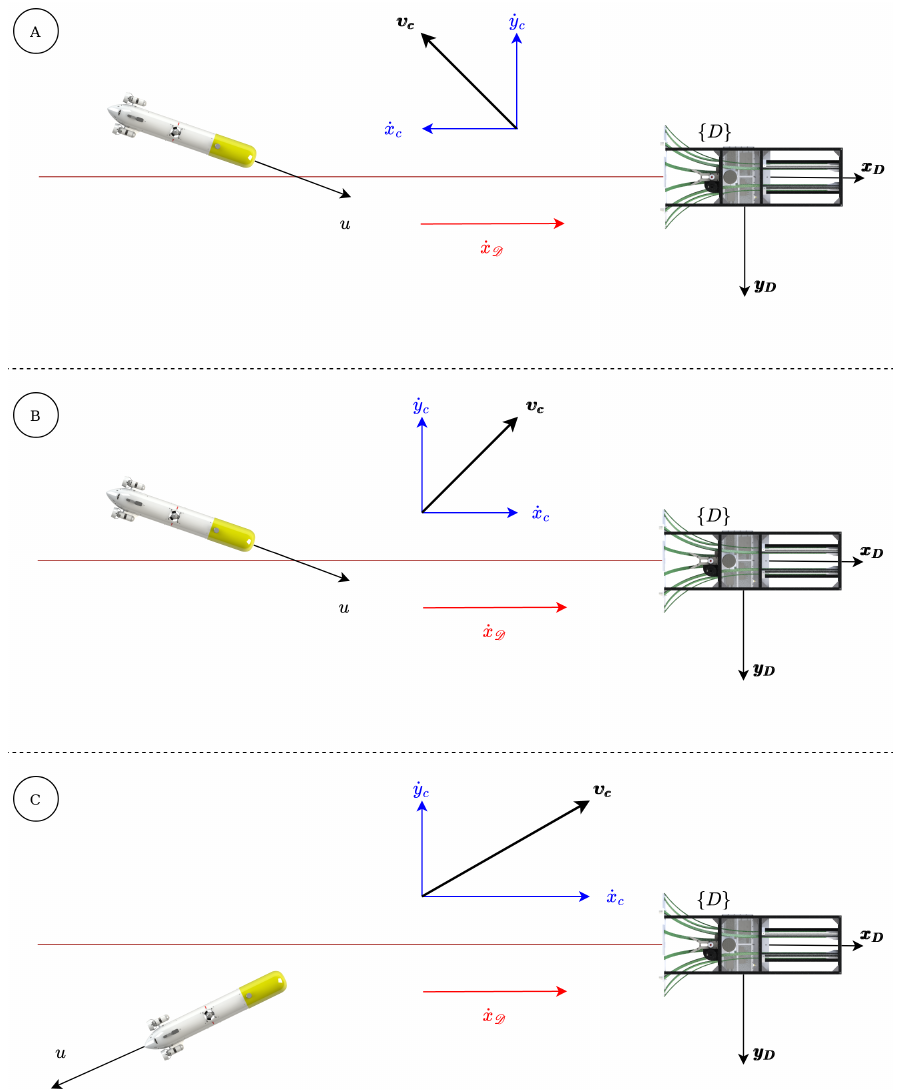
Figure 3. Possible docking